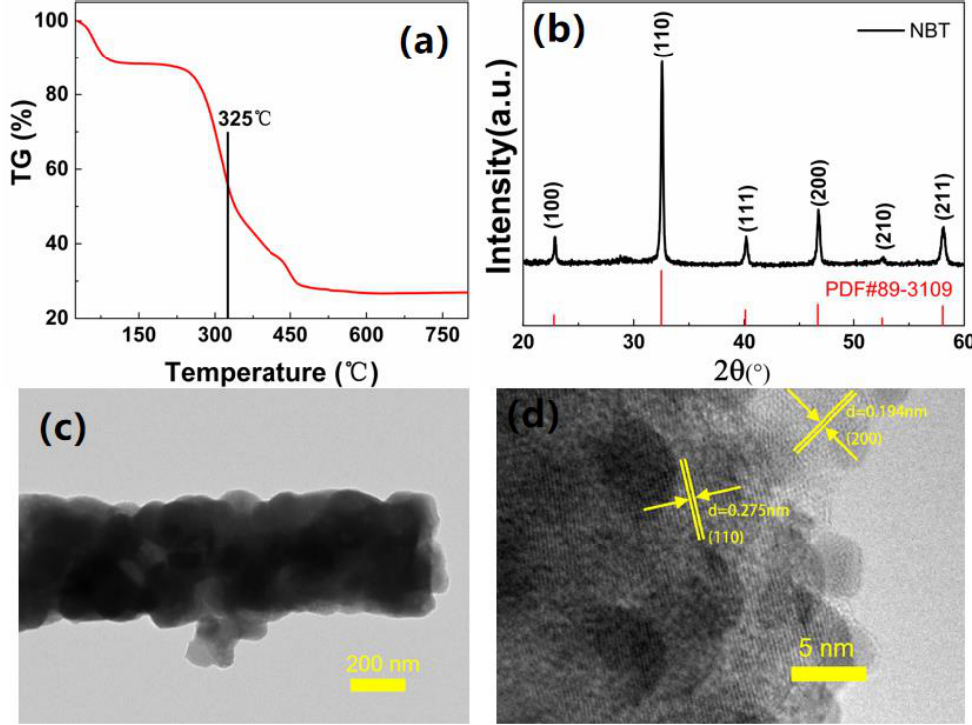
Figure 4. ( a ) TGA curve of electrospinning nanofiber; ( b ) XRD pattern; ( c ) TEM; ( d ) HRTEM of NBT nanofibers.